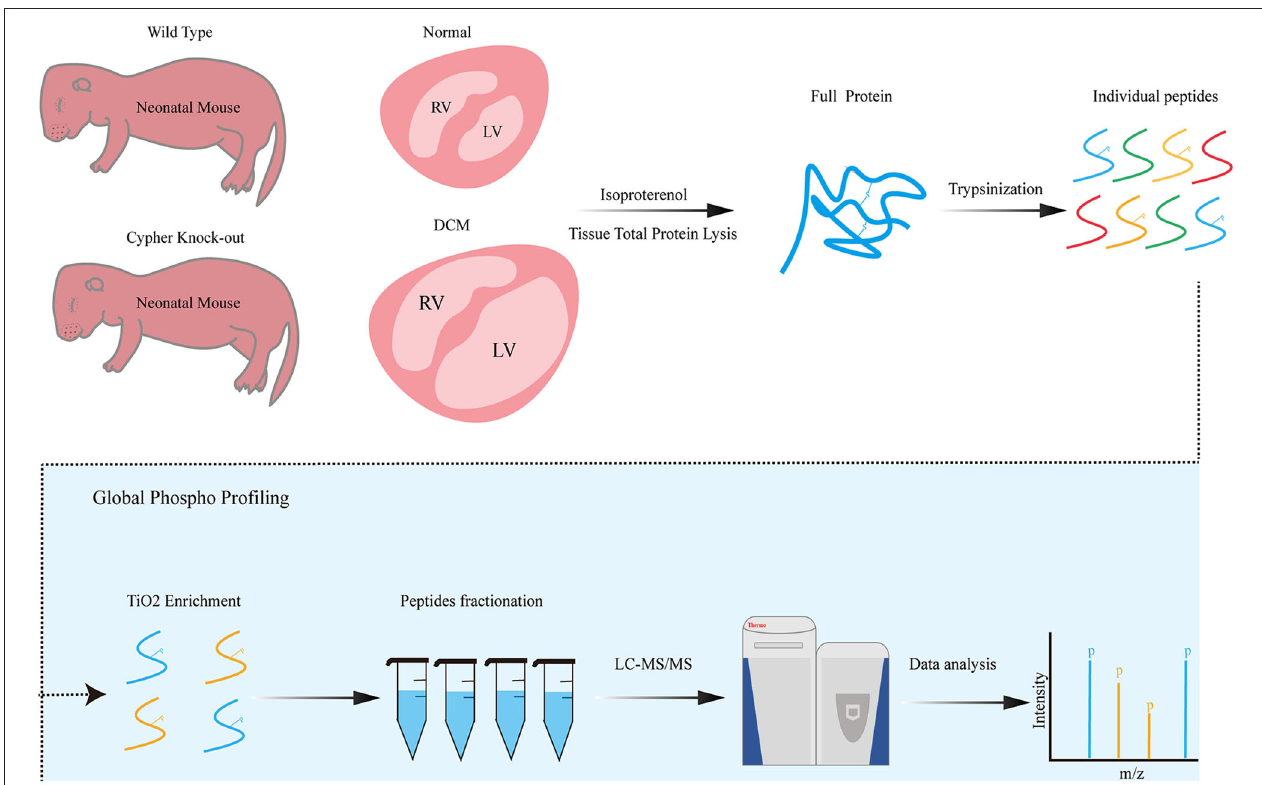
FIGURE 1 | Phosphoproteomics workflow. Neonatal wild-type and Cypher-knockout mice were administered isoproterenol (15 mg/kg, 30min) before the hearts were harvested. Heart tissue lysates were digested into peptides with trypsin overnight, followed by phosphopeptide enrichment using titanium dioxide spin tips. After washing, bound phosphopeptides were eluted and desalted with alkaline C18 for direct LC-MS analysis. Raw data were analysed using the MaxQuant software. DCM, dilated cardiomyopathy; isoproterenol, a PKA activator; TiO2, titanium dioxide; LC-MS, liquid chromatography–mass